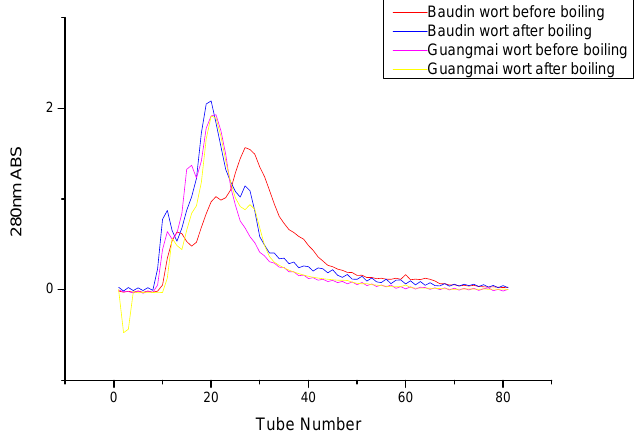
Figure 6. Gel-filtration protein profile of Baudin and Guangmai wort before and after boiling.